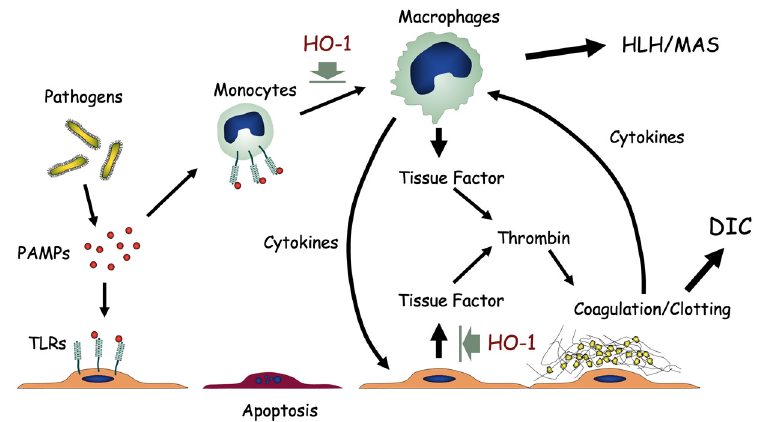
Figure 5. HO-1 deficiency and oxidative stress. Pathogen-associated molecular patterns (PAMPs) bind toll-like receptors (TLRs) on vascular endothelial cells or monocytes. Lack of HO-1 results in unregulated activation of macrophages with excess release of inflammatory cytokines. Hemophagocytic lymphohistiocytosis (HLH) or macrophage activation syndrome (MAS) may result. At the same time, HO-1 deficiency results in overproduction of tissue factors by endothelial cells, leading to abnormal activation of the coagulation/fibrinolysis system, and disseminated intravascular coagulation (DIC). Prolonged and sustained activation of monocytes, platelets and endothelial cells leads to exhaustion and dysfunction of these cells.